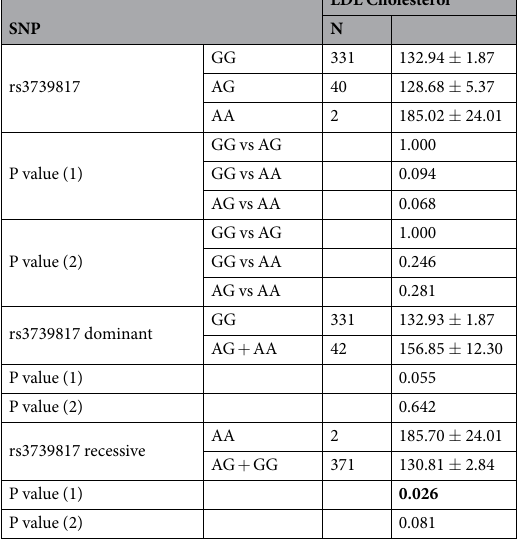
Table 7. Statistically significant results in the distribution of endoglin rs3739817 polymorphisms according to plasma LDL cholesterol. P value adjusted by sex and age (1) and by sex, age, DM, HTA, DL, tobacco, alcohol and BMI (2). SNP: single nucleotide polymorphism. Statistically significant results in